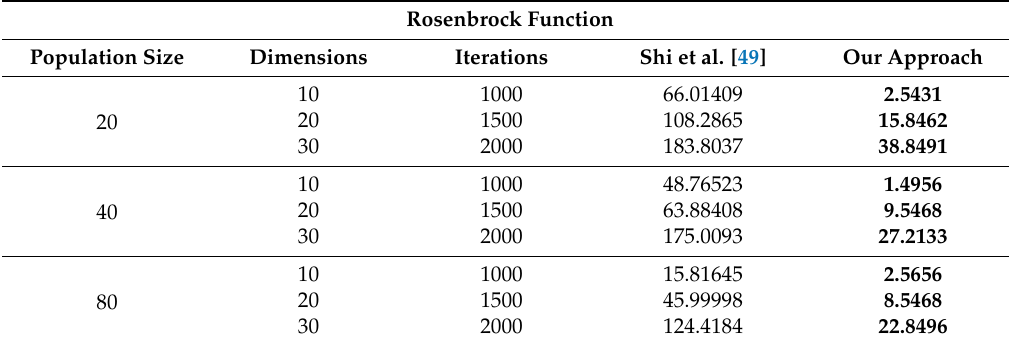
Table 16. Comparison against Shi et al. [49].